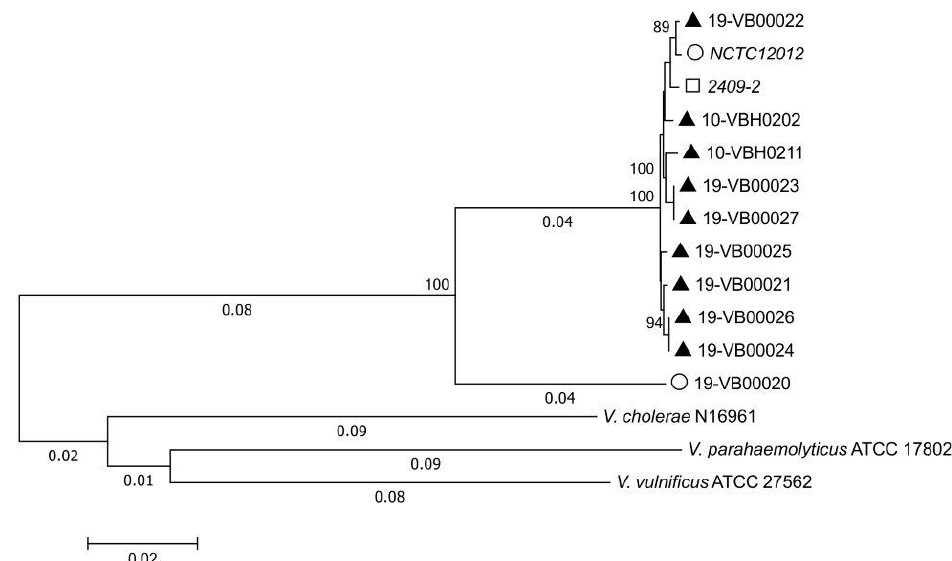
Figure 2. Phylogenetic tree of V. cincinnatiensis strains and different Vibrionaceae strains based on concatenated sequences in the order atpA-gyrB-pyrH-recA (1964 bp) constructed using MEGA7 [20]. Symbols: veterinary strains ( ▲ ), human strains (О), and unknown origin (□) . The evolutionary history was inferred using the neighbor-joining method. The optimal tree with the sum of branch length = 0.46004156 is shown. The percentages of replicate trees in which the associated taxa clustered together in the bootstrap test (1000 replicates) are shown next to the branches (only values above 70% are shown). The tree is drawn to scale, with branch lengths (next to the branches) in the same units as those of the evolutionary distances used to infer the phylogenetic tree. The evolutionary distances were computed using the Kimura 2-parameter method and are in the units of the number of base substitutions per site. V. cincinnatiensis strain 2409-02 was deposited by CDC